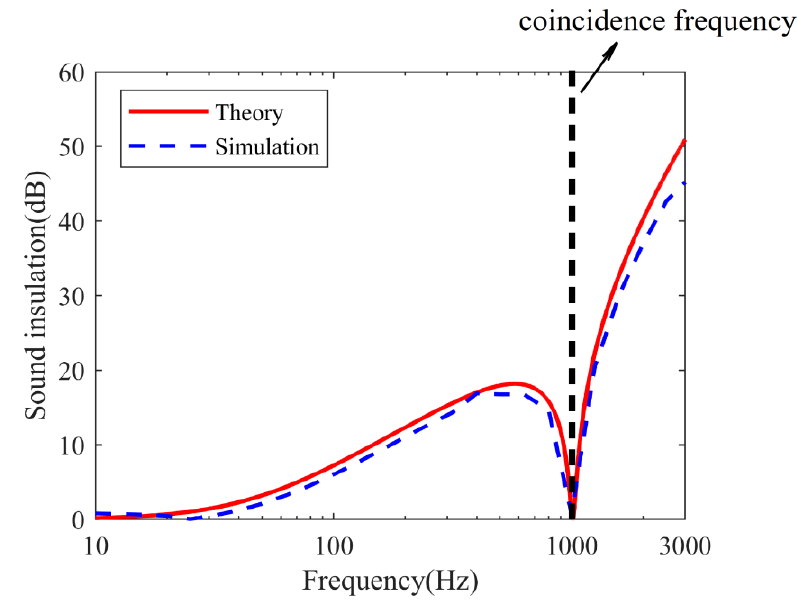
Figure 6. Comparison of theory and simulation results.